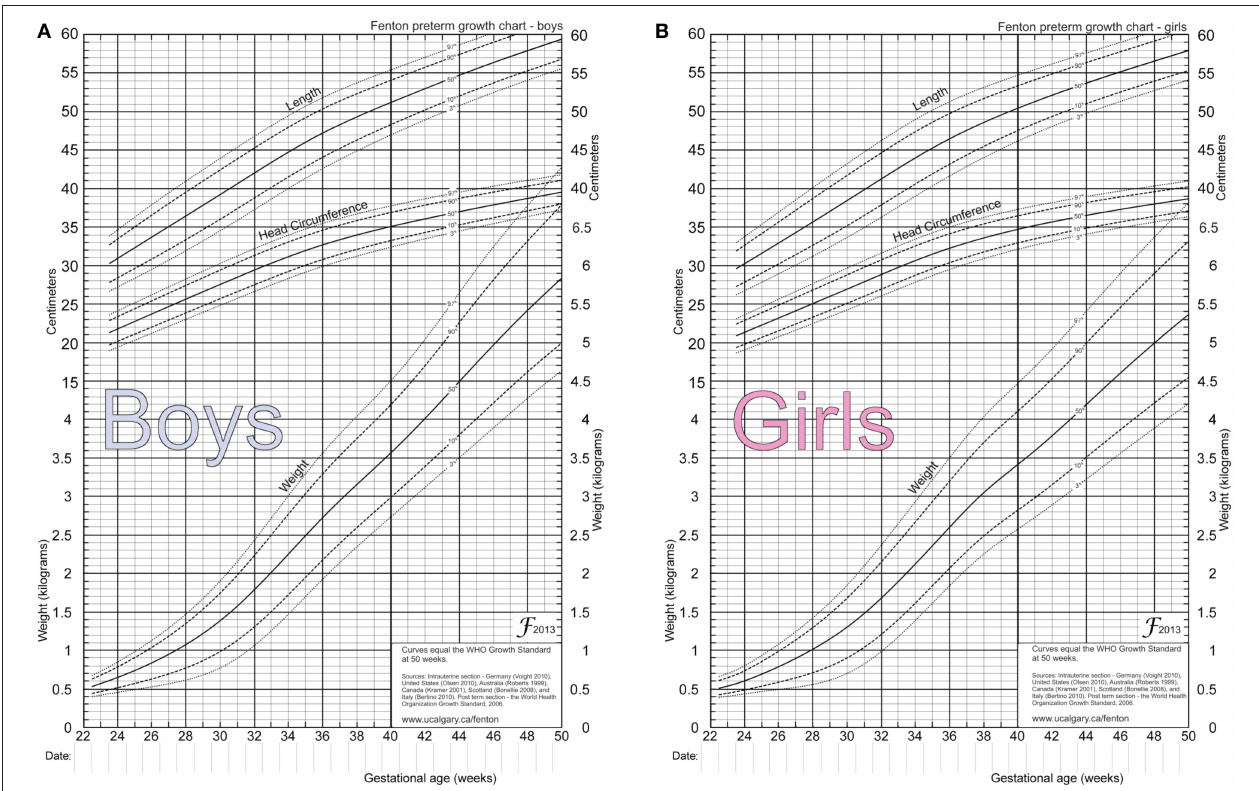
FIGURE 1 | 2013 Fenton preterm growth charts for newborns. (A) Is the 2013 Fenton preterm growth chart for boys. (B) Is the 2013 Fenton preterm growth chart of